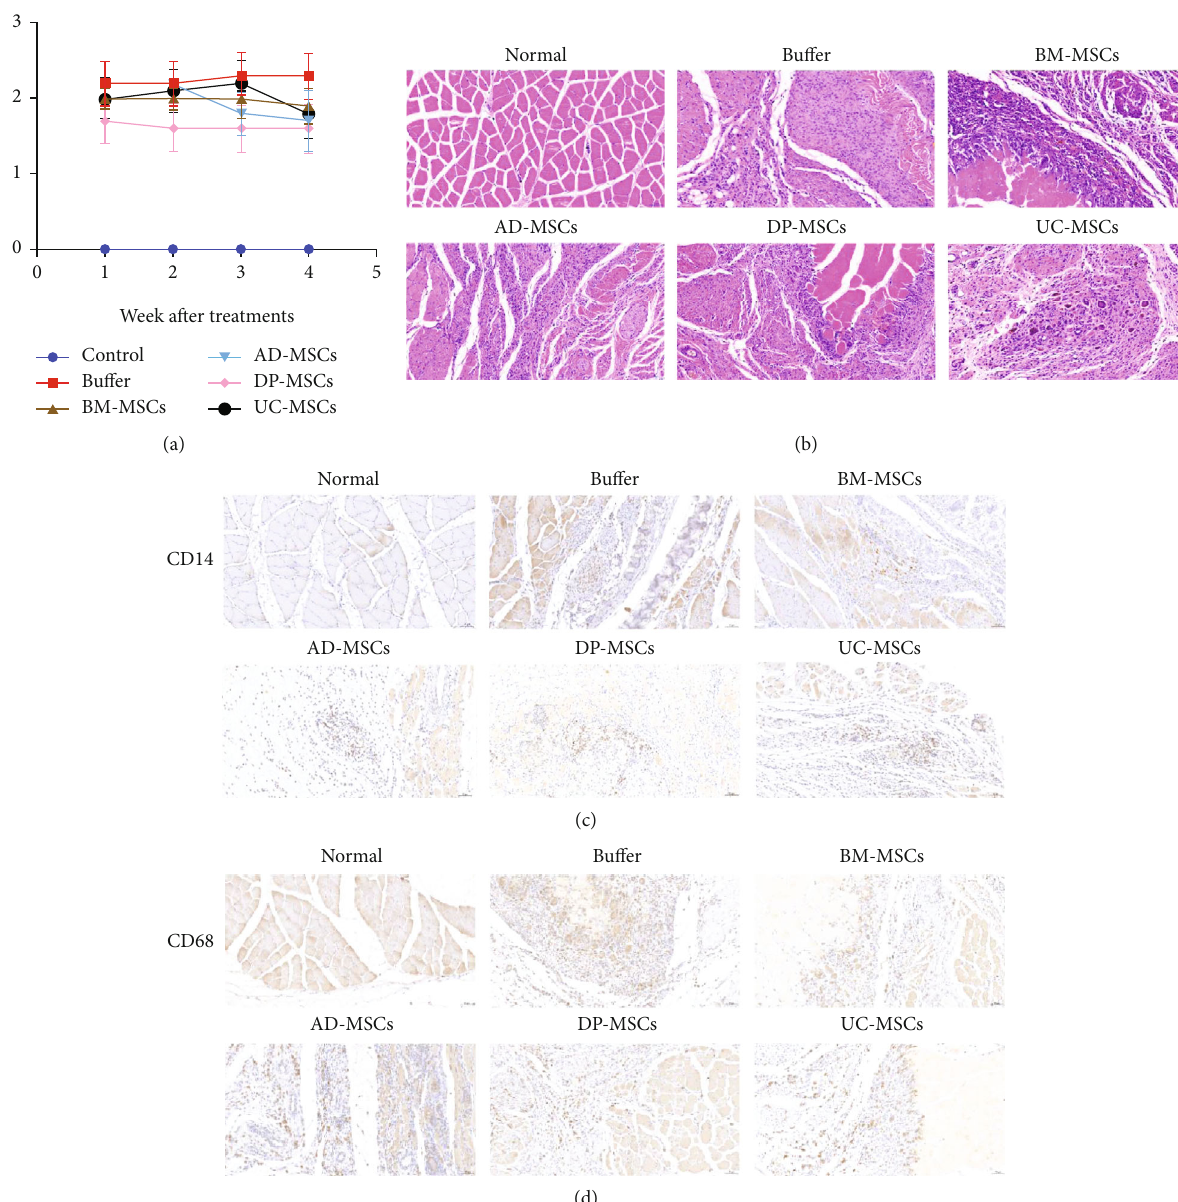
Figure 1: MSCs improve limb functions and reduce ischemia-induced damage. Sixty 6-8-week-old Wistar rats were divided into 6 groups: bone marrow-derived MSCs (BM-MSCs), adipose-derived MSCs (AD-MSCs), dental pulp-derived MSCs (DP-MSCs), umbilical cord- derived MSCs (UC-MSCs), bu ff er, and control groups. Rats in BM-MSCs, AD-MSCs, DP-MSCs, UC-MSCs, and bu ff er-treated groups received surgical ligation of two branches of the left femoral artery near the groin. Then, 5 × 10 6 BM-MSCs, AD-MSCs, DP-MSCs, and UC-MSCs and 300 μ l PBS were injected intramuscularly into the ischemic area of hind limbs, respectively. Semiquantitative assessments of limb function were performed at 1, 2, 3, and 4 weeks after therapy, and higher scores represent much more severe damage (a). At 4 weeks after MSC transplantation, the muscular tissues in the ischemic area were collected, fi xed in 4% formaldehyde solution, processed, and stained with hematoxylin and eosin (H&E). The representative images are shown in (b). The distributions of CD14 + cells and CD68 + cells were analyzed by immunohistochemistry using an anti-rat CD14 antibody and anti-rat CD68 antibody. The representative images are shown in (c) and (d), respectively. Data in (a) were shown as mean ± s : e : m